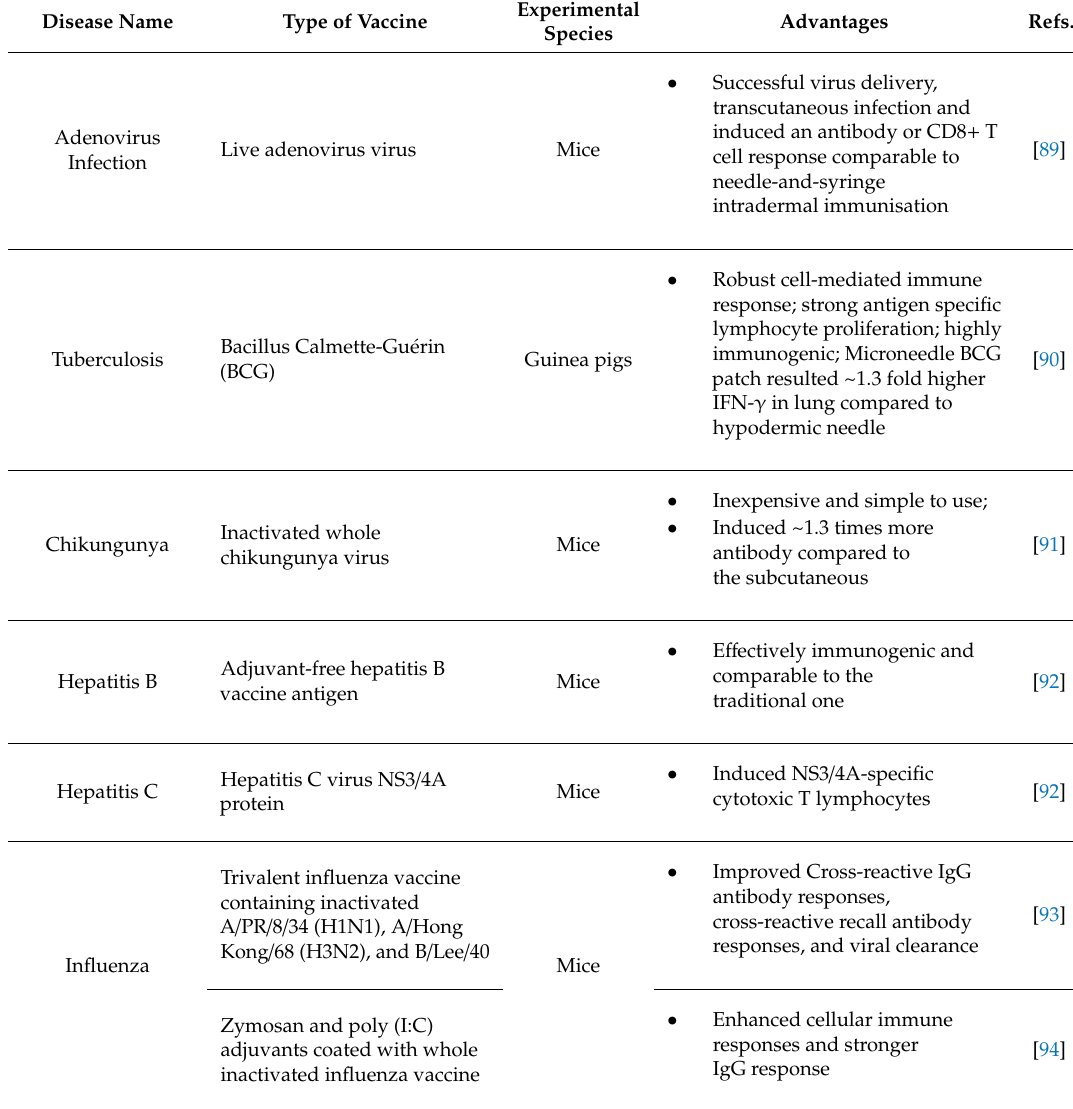
Table 2. A summary of studies on the delivery of vaccines using coated